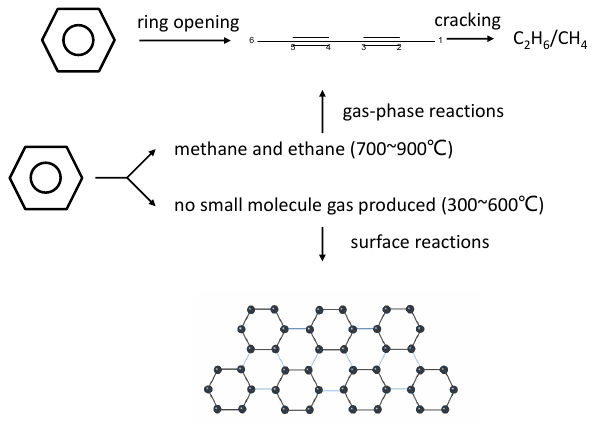
Figure 2. Mechanism of graphene growth from benzene at different temperatures (300~900 °C).